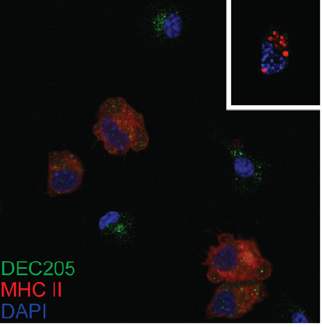
Figure 9. Surface mobilisation of MHC class II upon LPS activation of DEC205-expressing adherent cells. Adherent spleen cells were stimulated with LPS for three hours, permeabilised, and stained with AD6 anti-DEC205 antibody (green) and 2G11 anti MHC class II antibody (red). Nuclei were revealed with DAPI (blue). The inset shows an image of an unstimulated cell stained in the same way.